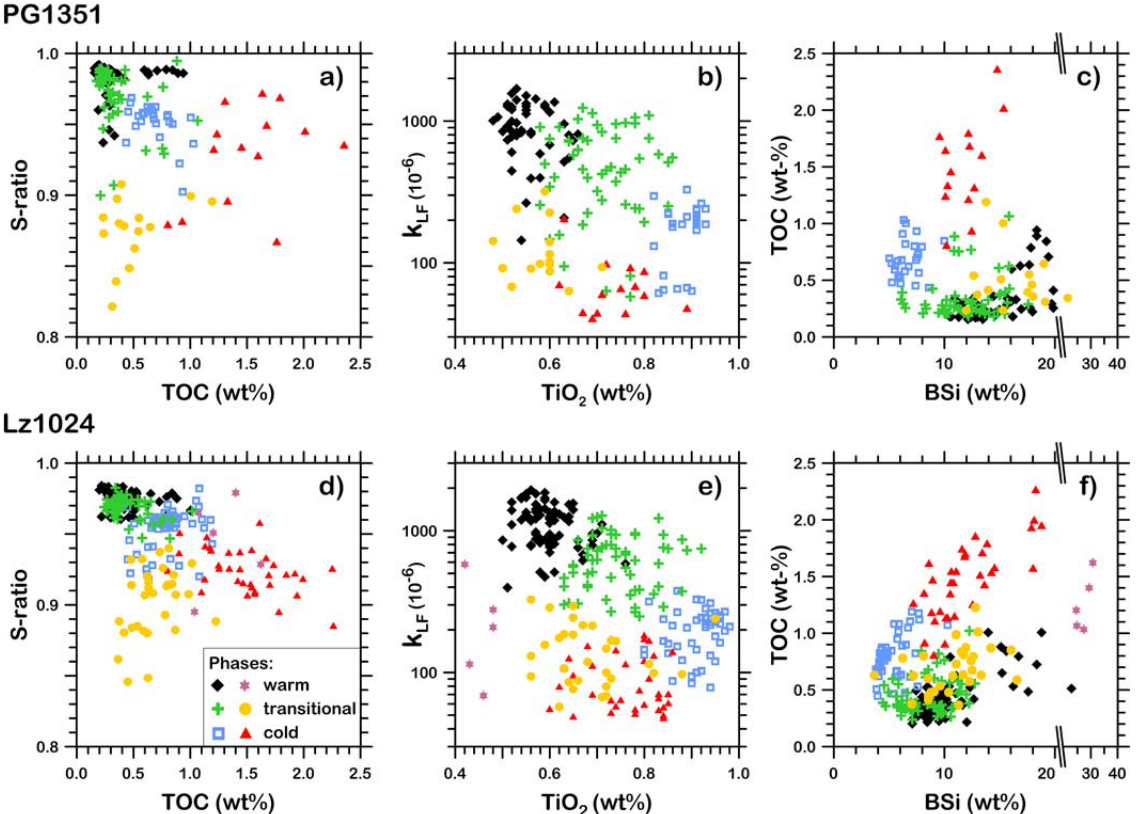
Fig. 5. Defining the sediment characteristics of the different climatic phases identified in PG1351 (a–c) and Lz1024 (d–f) by combining the parameters used for cluster analysis in a series of scatter plots. (a) and (d) : TOC versus S-ratio (both are indicative for oxic/anoxic conditions); (b) and (e) : TiO 2 (lithogenic contribution) versus κ LF (oxic/anoxic conditions); (c) and (f) : BSi (diatom content) versus TOC (oxic/anoxic conditions). More detail on the subdivision of the samples into six clusters is given in the